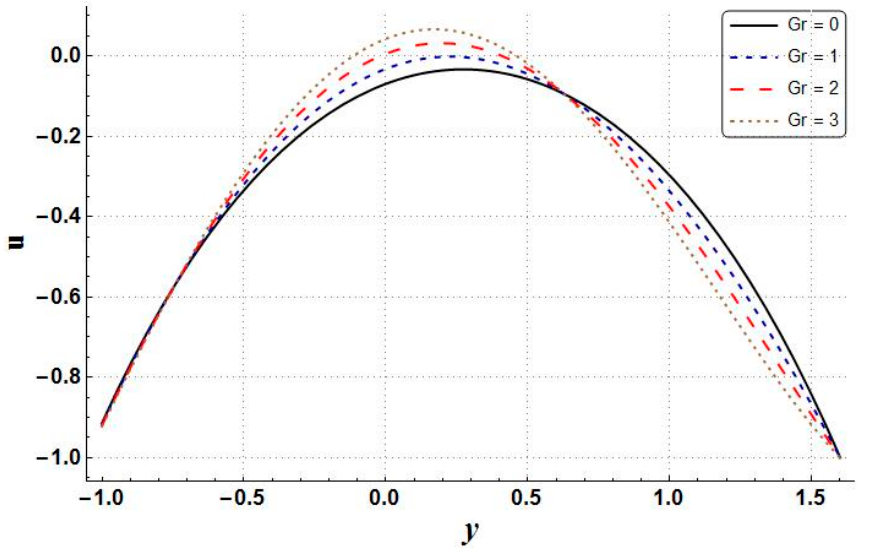
Figure 15. Influence on u through changing values of Gr , where γ = π φ = 0.05, k = 2, a = 0.6, M = 1, d = 0.7, m = 1, b = 0.5, ∈ = 2, η =